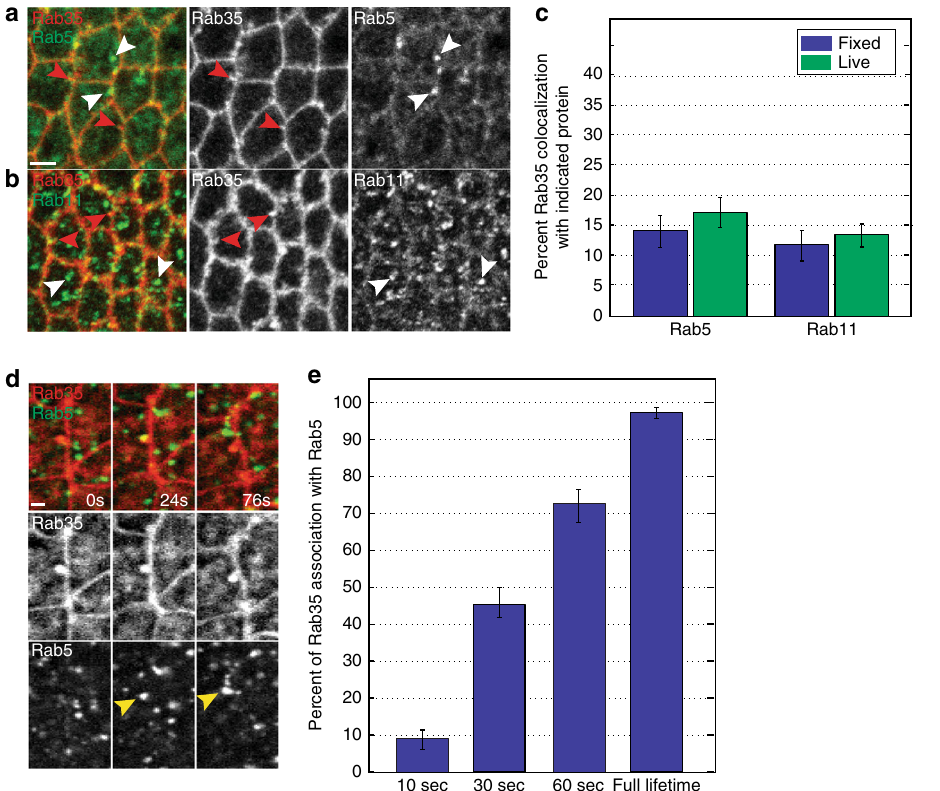
Fig. 6 Rab35 compartments direct endocytic membrane to endosomes. a , b Rab35 has a low degree of colocalization with Rab5 ( a , green ) or Rab11 ( b , green ) in fi xed tissue by immuno fl uorescence. White arrowheads indicate typical Rab5 ( a ) or Rab11 ( b ) compartments, while red arrowheads indicate interfacial Rab35 compartments ( a , b ). c Quanti fi cation of colocalization in a , b . n = 210 ( fi xed, with Rab5), 198 (live, with Rab5), 245 ( fi xed, with Rab11), and 259 (live, with Rab11) compartments. d Live imaging of YFP:Rab5 ( green ) and mCh:Rab35 ( red ). An AP Rab35 compartment (0 s) displays no association with Rab5. Later in the lifetime of the Rab35 compartment (24 s) a Rab5 early endosome associates with the compartment ( yellow arrowhead ) and grows in size before separating (76 s). e Quantitation of association between Rab35 compartments and Rab5. Rab35 compartments are increasingly likely to associate with early endosomal Rab5 as they progress toward the end of their lifetimes. n = 197 compartments. Error bars indicate standard error. Scale bars are 2.5 microns in a and 1.25 microns in